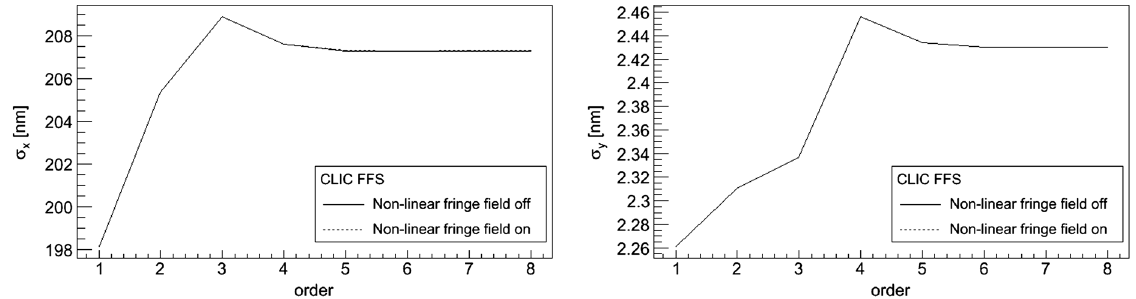
FIG. 9. Nonlinear fringe field impact on the horizontal (left) and vertical (right) beam size in the CLIC BDS